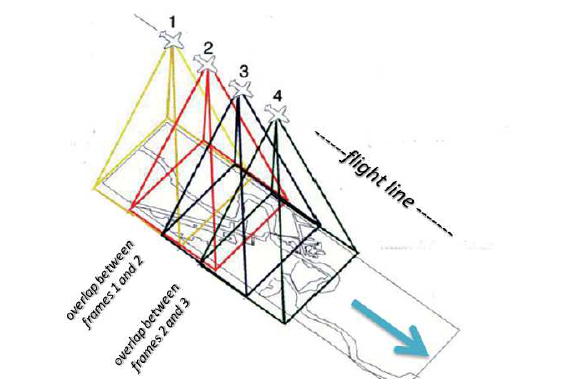
Figure 1. Case of a traditional photogrammetric airplane acquisition